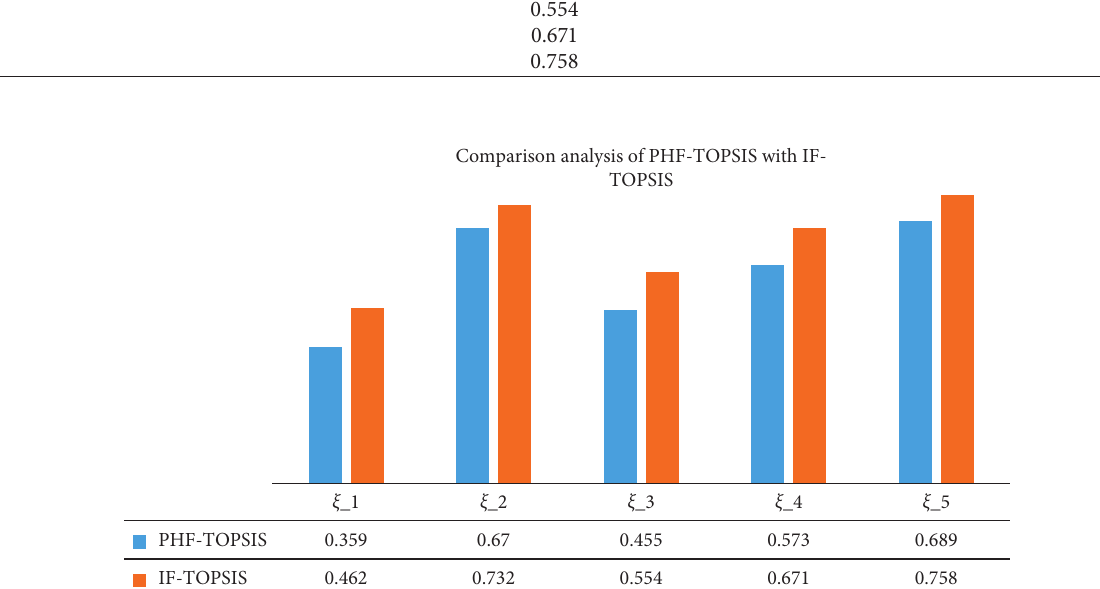
Figure 2: The graph of score values of ξ